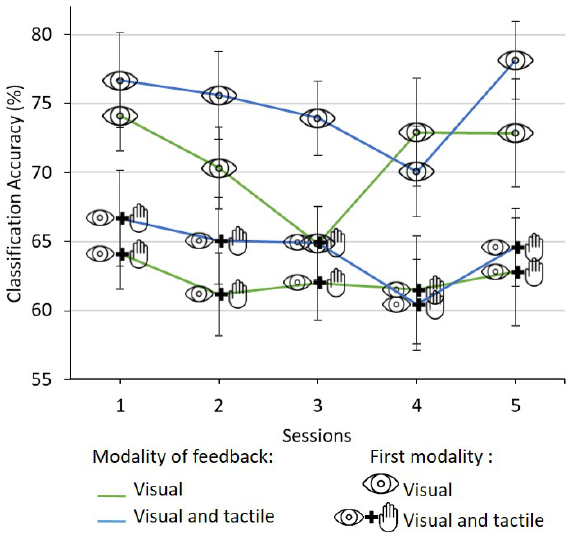
Figure 5. Evolution of the motor imagery (MI) classification accuracy over the sessions depending on the modality of feedback and its order of